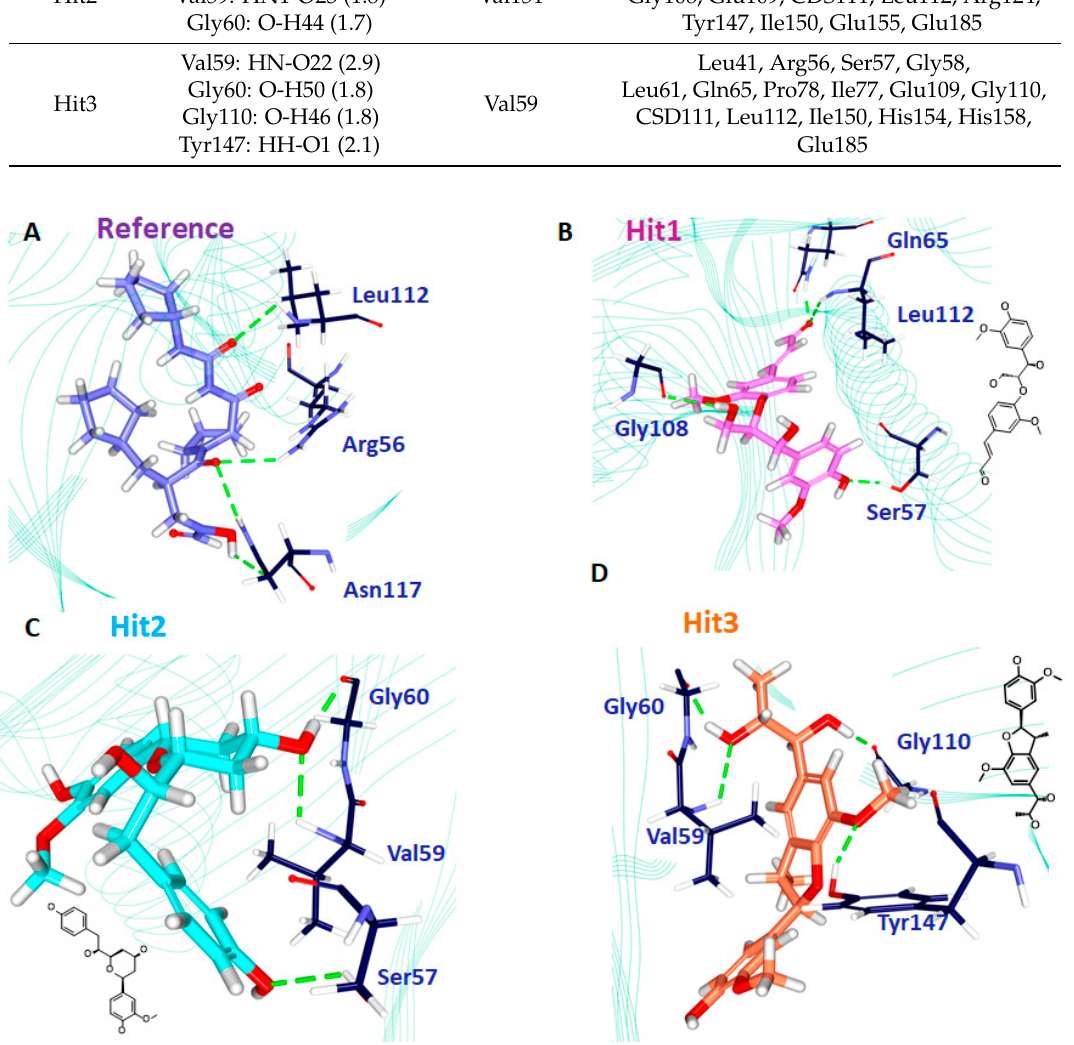
Figure 7. Intermolecular hydrogen bond interactions of the reference ( A ), Hit1 ( B ), Hit2 ( C ), and Hit3 ( D ), respectively.